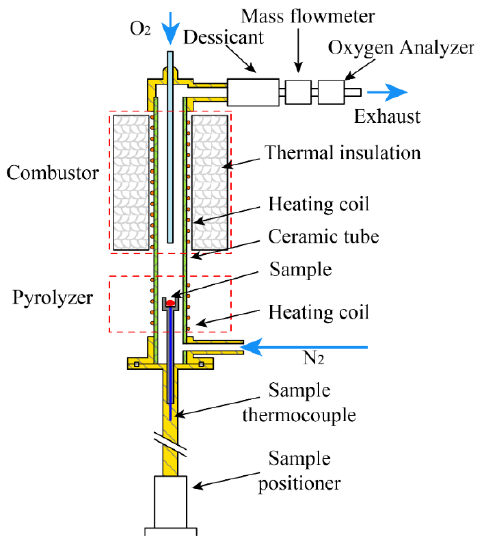
Figure 1. Schematic of the apparatus of the Microscale Combustion Calorimeter [30].